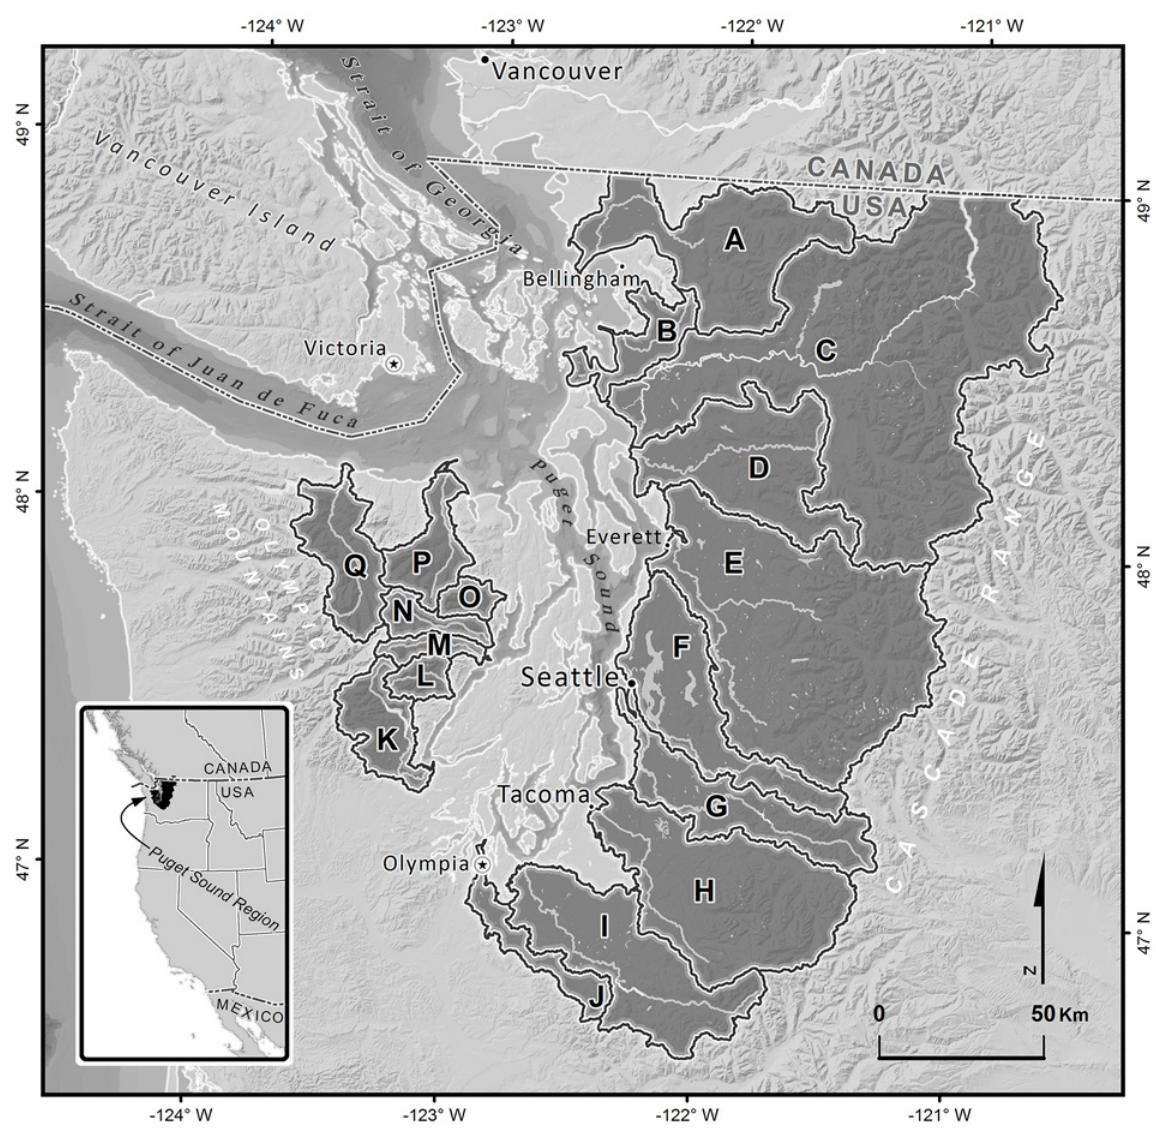
Fig 1. Puget Sound Region Map. Map of the Puget Sound region of Washington State (inset), including the 17 major watersheds analyzed in our study. A — Nooksack, B — Samish, C — Skagit, D — Stillaguamish, E — Snohomish, F — Lake Washington, G — Duwamish, H — Puyallup, I — Nisqually, J — Deschutes, K